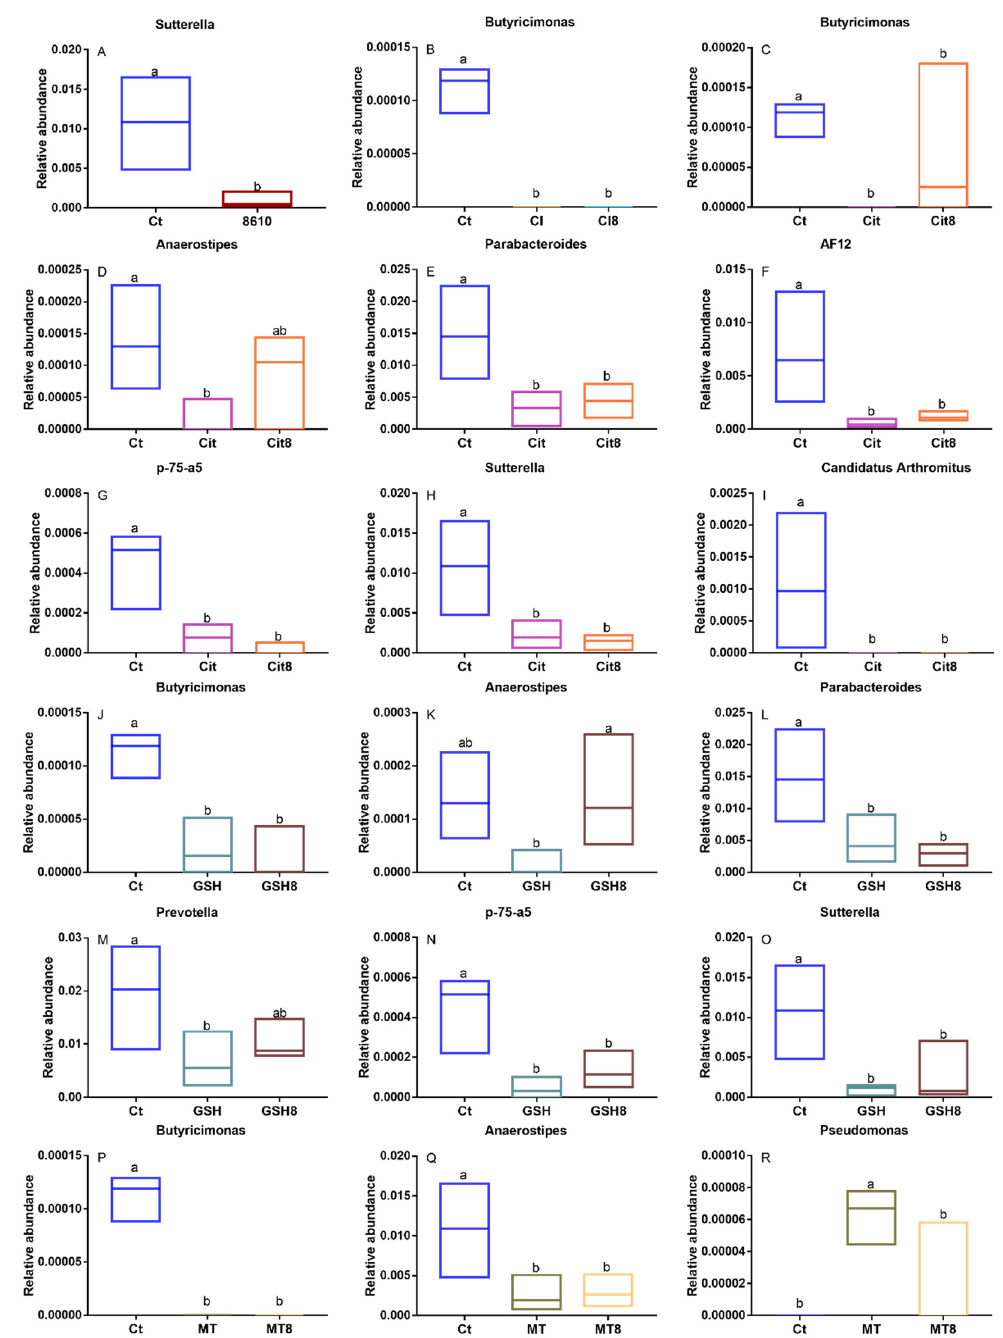
Figure 4. Analysis of the changes in the abundance of microflora in different groups. ( A , B ). Changes in CdCl 2 treatment groups. ( C – I ). Changes in Cd–citrate treatment groups. ( J – O ). Changes in Cd–GSH treatment groups. ( P – R ). Changes in Cd–MT treatment groups.